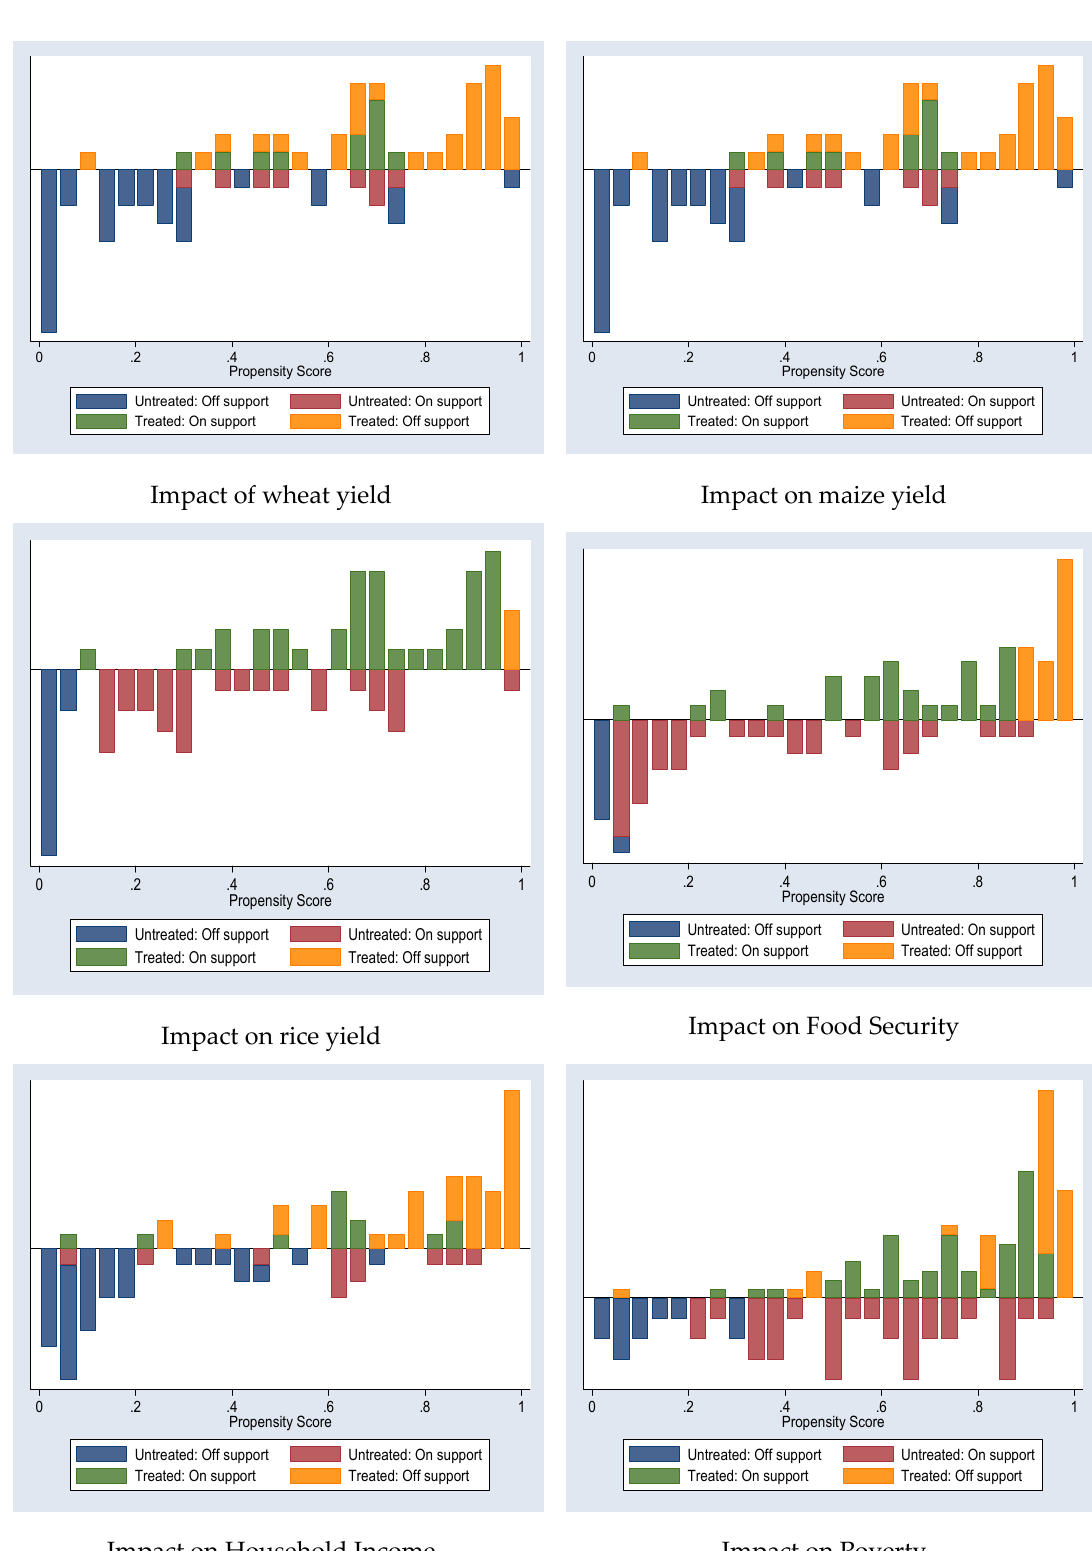
Figure 2. Indicators of covariate balancing before and after matching.